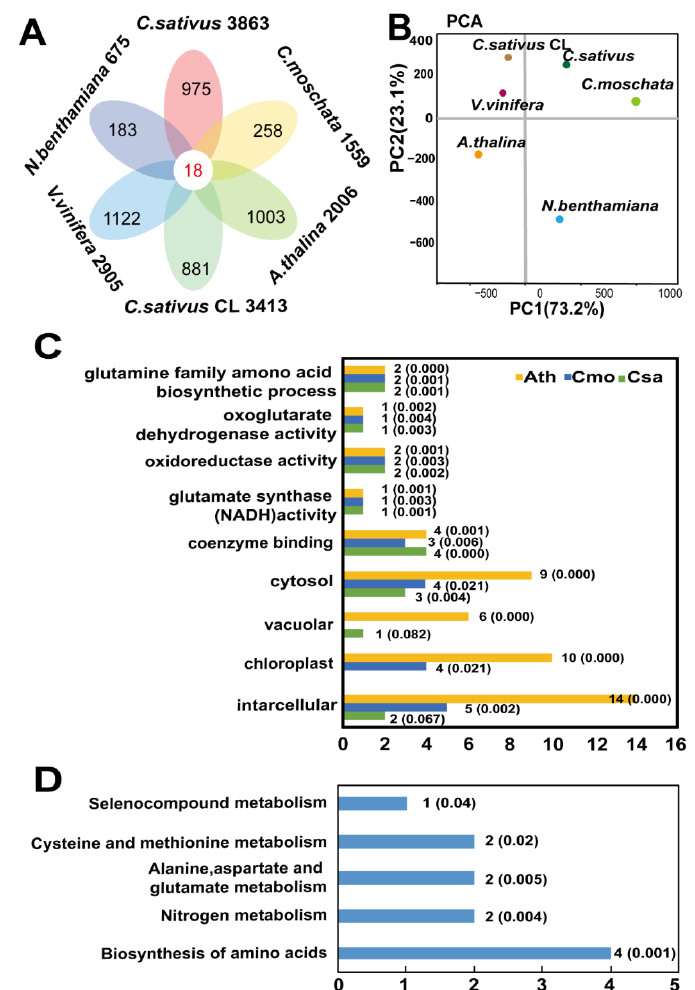
Figure 5. Characterization of orthologous mobile mRNAs identified in different heterograft systems. ( A ) Venn diagram of orthologous mobile mRNAs identified in all six heterograft systems. Mobile